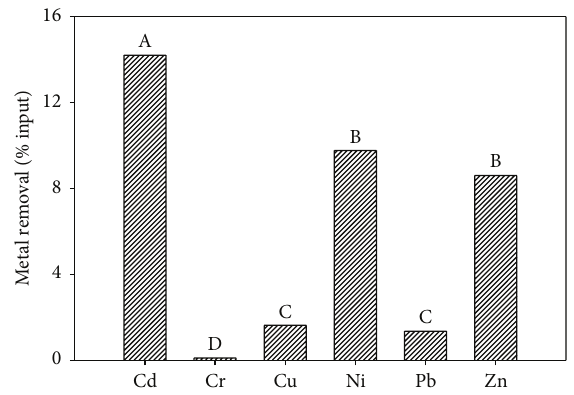
Figure 1: Metal removal by corn shoot and root grown on sand media amended with